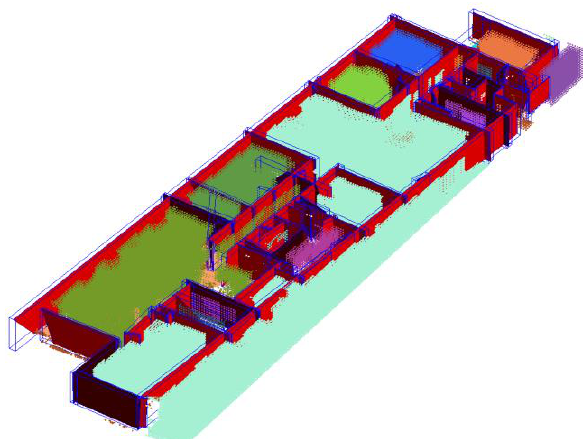
Figure 10. A 3D model of walls and space partitions. This model can be further processed to reconstruct a watertight model.